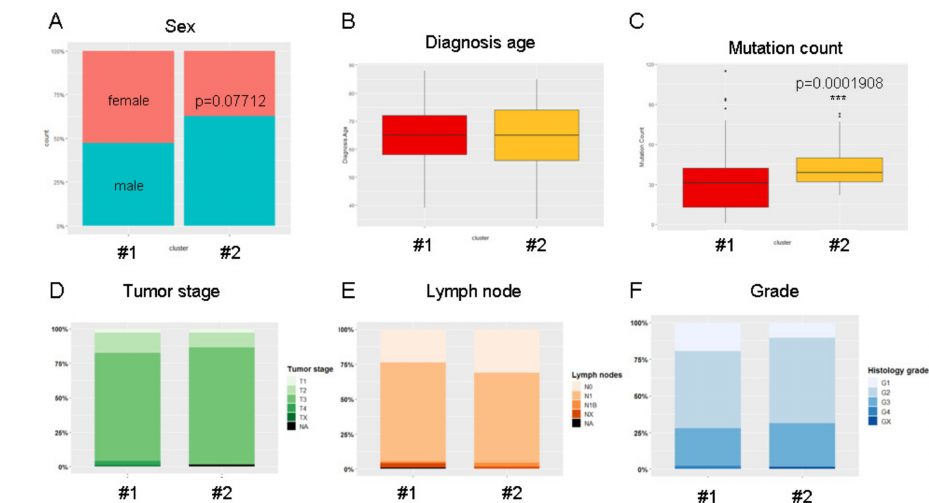
Figure 6. The mucin-based stratification is independent of clinical features and is associated with the mutation count in PDAC patients. ( A ) Percentage-staked bar plot of sex distribution in PAAD-TCGA cohort of clusters #1 and #2. Boxplots showing age of diagnosis ( B ) and mutation counts ( C ) for clusters #1 and #2 (***, p < 0.001). Percentage-staked bar plot showing tumor stage (T1 / T2 / T3 / T4 / TX / NA) ( D ), lymph node status (N0 / N1 / N1B / NX / NA) ( E ), and di ff erentiation grades (G1 / G2 / G3 / G4 / GX) ( F ) in clusters #1 and #2.